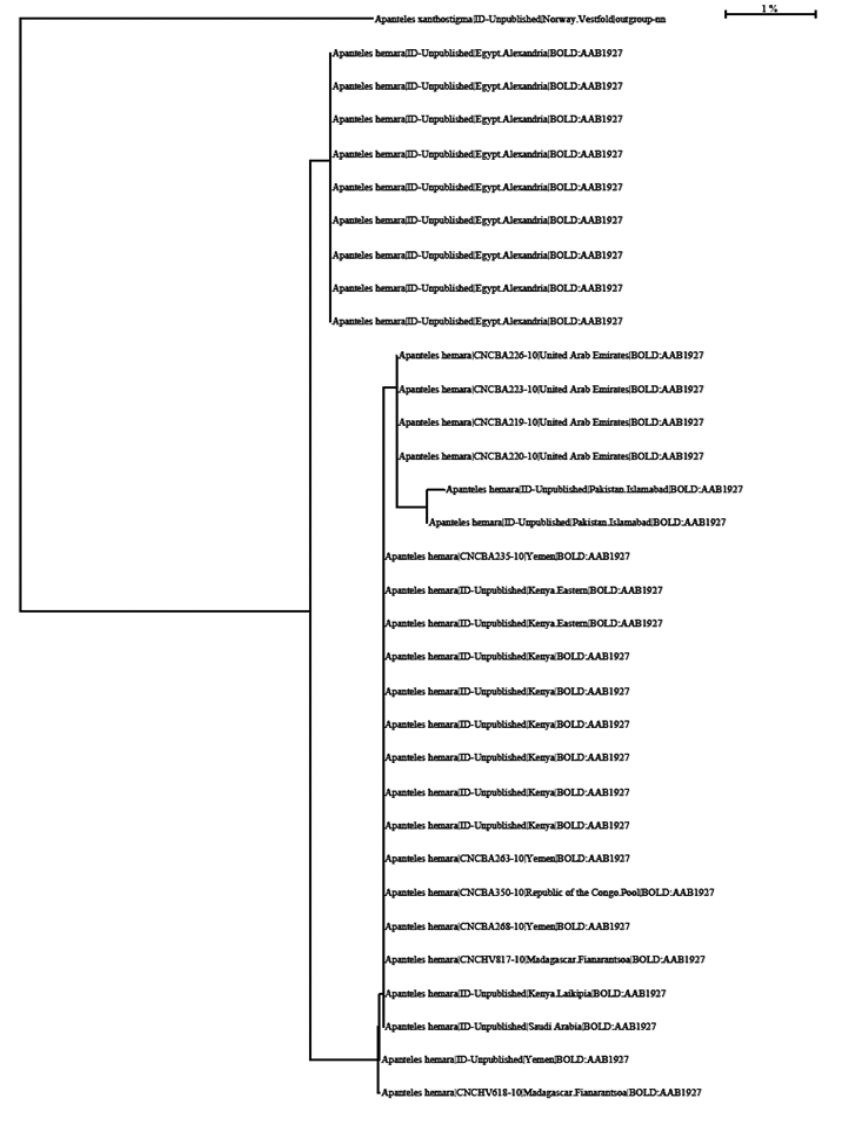
Figure 3. Neighbour Joining tree (K2P) of all known DNA barcoding sequences of Apanteles hemara and a representative of the closer species ( Apanteles xanthostigma ) in the BOLD database (as of April